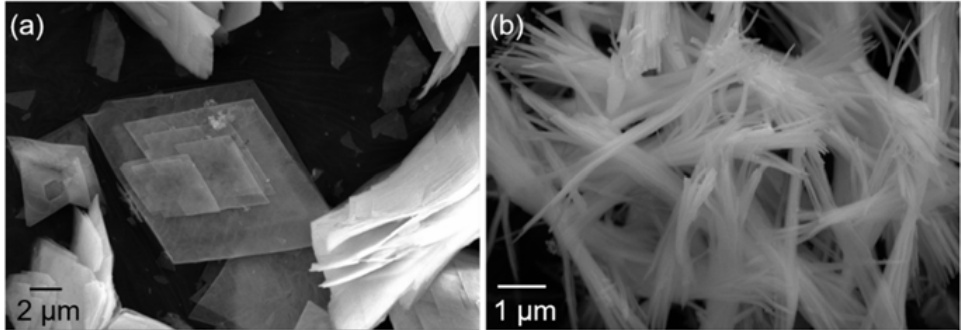
Figure 6. XRD pa tt erns of y tt ria precursor after calcining at di ff erent temperatures.